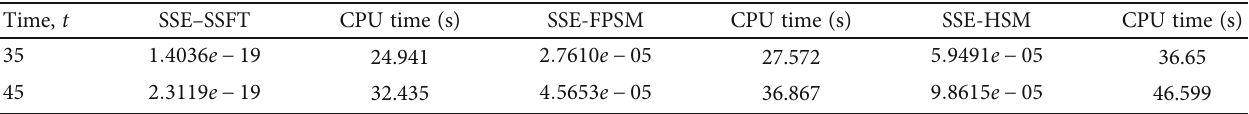
Table 2: A comparison among the sum of squares error (SSE) of the split-step Fourier transform (SSFT), the Fourier pseudospectral method (FPSM), and the Hopscotch scheme (HSM), computed for di ff erent time values t from 35 to 105 : When h = 0 : 2 and τ = 0 : 0001 . Time,